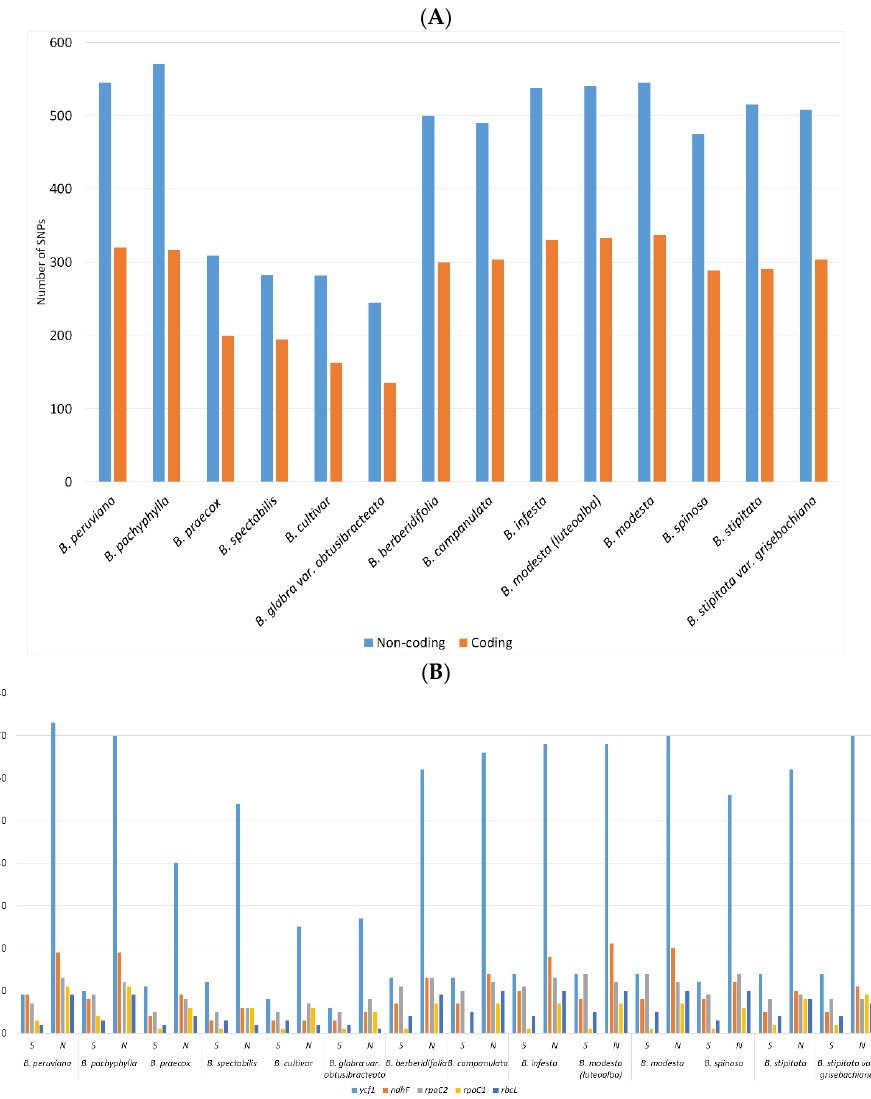
Figure 2. Total number of SNPs identified in the plastid genomes of Bougainvillea . ( A ) Number SNPs observed in the coding and non-coding sequences. ( B ) Coding sequences with greatest occurrence of synonymous and non-synonymous